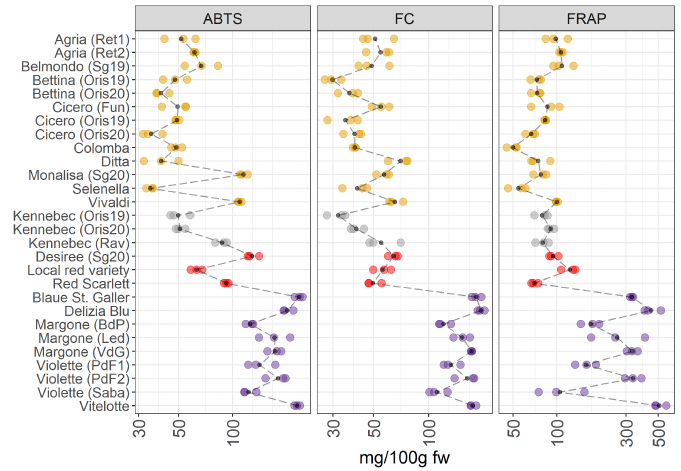
Figure 3. ABTS, FC, and FRAP in 28 potato varieties organized in four groups (yellow-, white-fleshed, red-skinned, and purple-fleshed); three biological replicates for each sample were analyzed. The black points represented the averages for each analyte calculated on three biological replicates. The black long dash lines showed the concentration trends amongst all the potato groups. The concentrations were transformed in a log-10-scale. fw = fresh weight. For more detailed information about potato varieties see Table